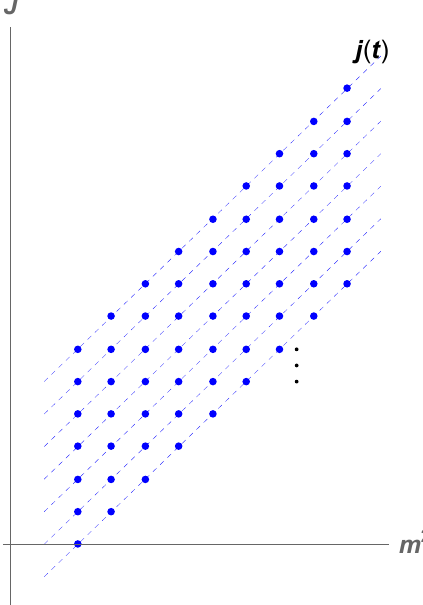
Figure 14 . We couple a theory of metastable HS particles to gravity. This is a schematic plot of the spectrum of particles with large spins that the gravity sector must contain in the resulting theory. Blue dots represent actual particles and dashed blue lines are Regge trajectories, where the origin of the axes is arbitrary. Consistency of the S-matrix requires that the Regge trajectories must be asymptotically linear, parallel, and equispaced. Note that there are an infinite tower of particles for any fixed